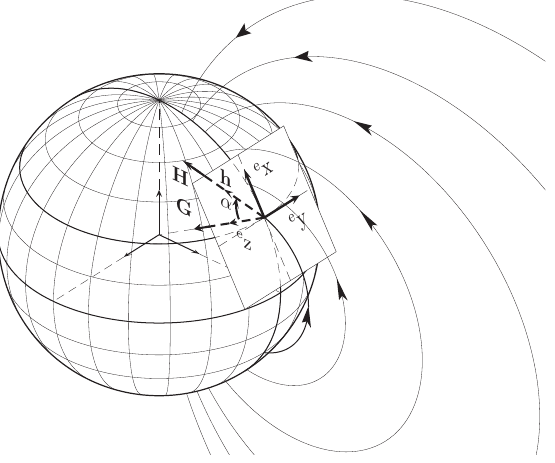
Figure 1. Earth reference